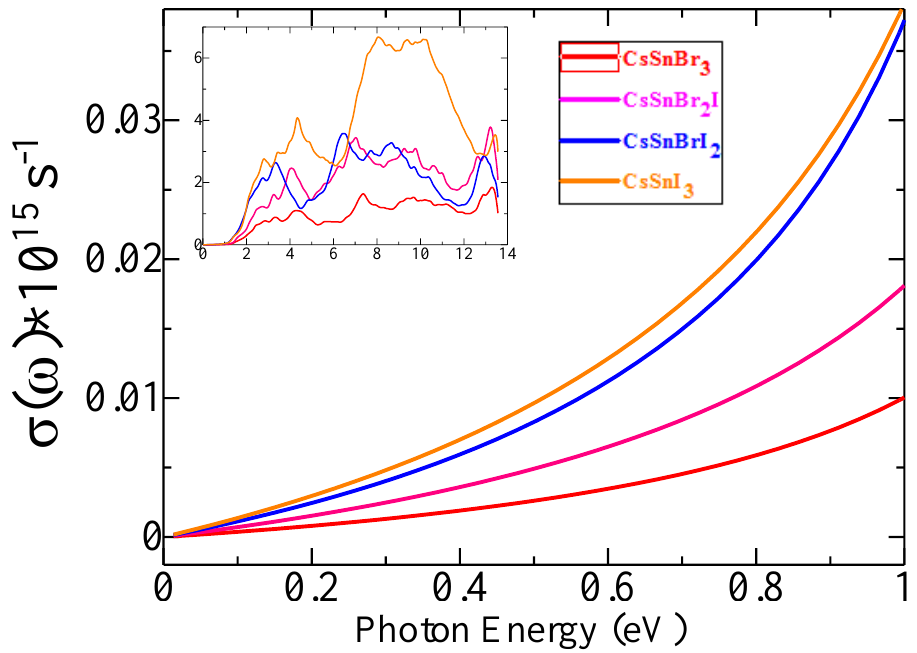
Figure 4. Optical conductivity spectra of the CsSnBr3-xIx system as a function of energy (insert: σ(ω) in the range from 0 to 14 eV) The calculated light reflectance spectra R(ω) for IR radiation are shown in Figure 5 for all investigated materials.